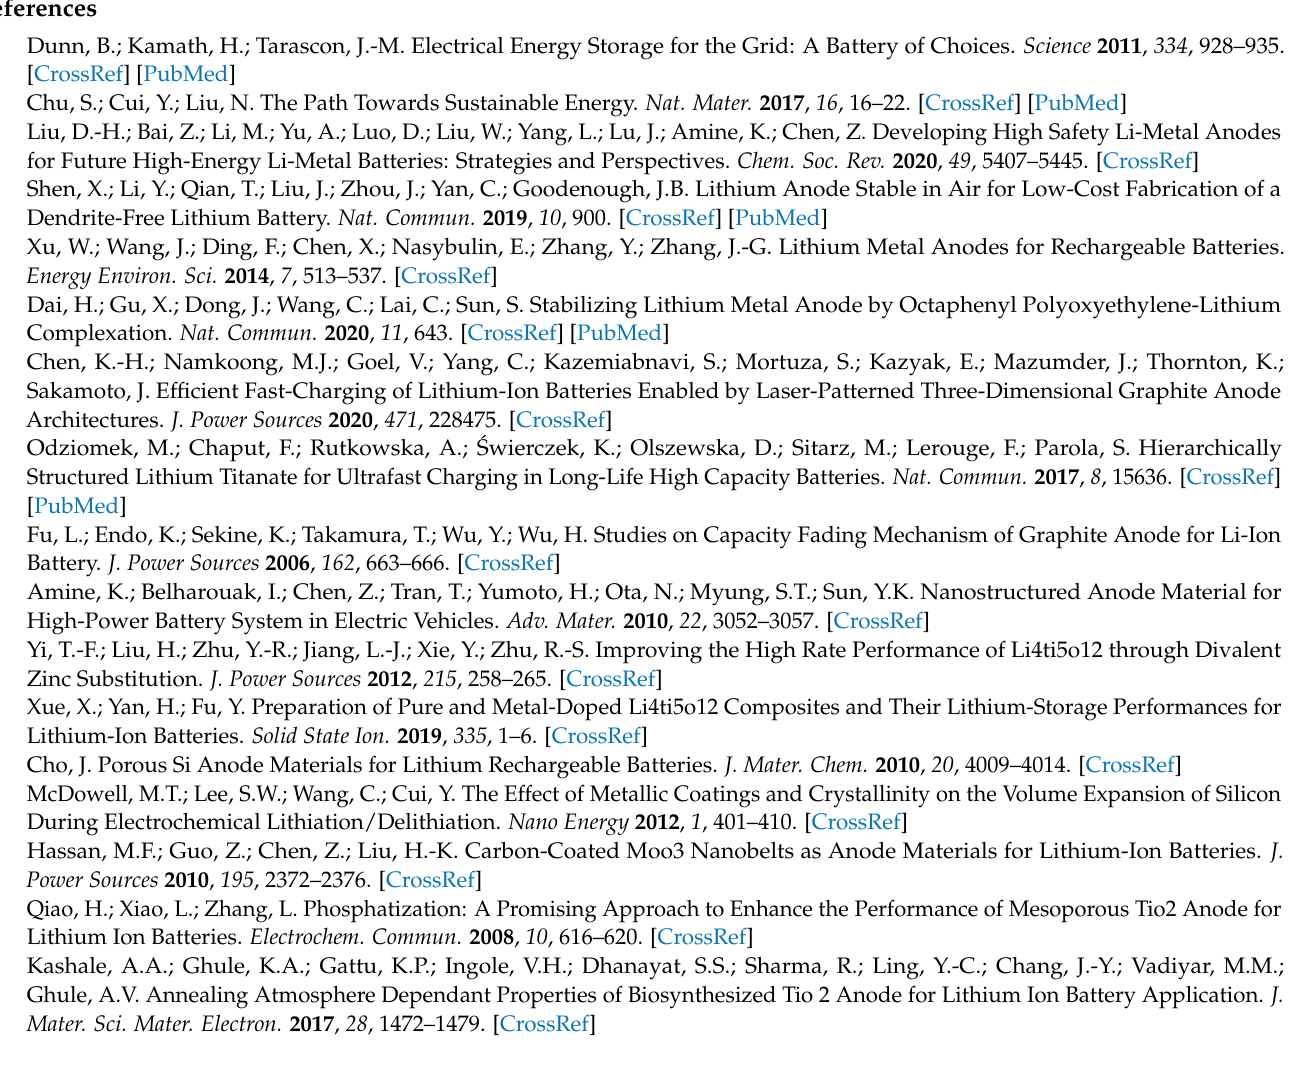
Cycling performance of CsPbI 3 anode materials at different C-rate.; Figure S19: KK compatibility test.; Table S1: Ground state energy for different configuration of lattice sites with different concentration of